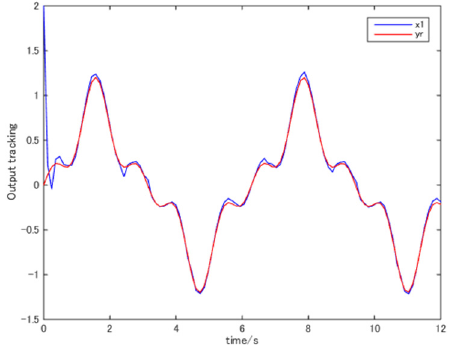
Figure 5. The trajectories of ( )